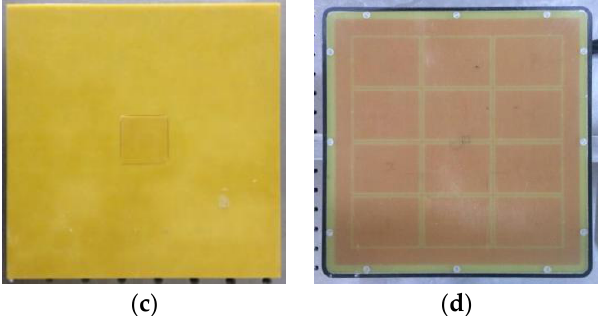
Figure 9. Test samples: ( a ) sample 1, center defect; ( b ) sample 2, edge defect; ( c ) high calibration; and, ( d ) low calibration.